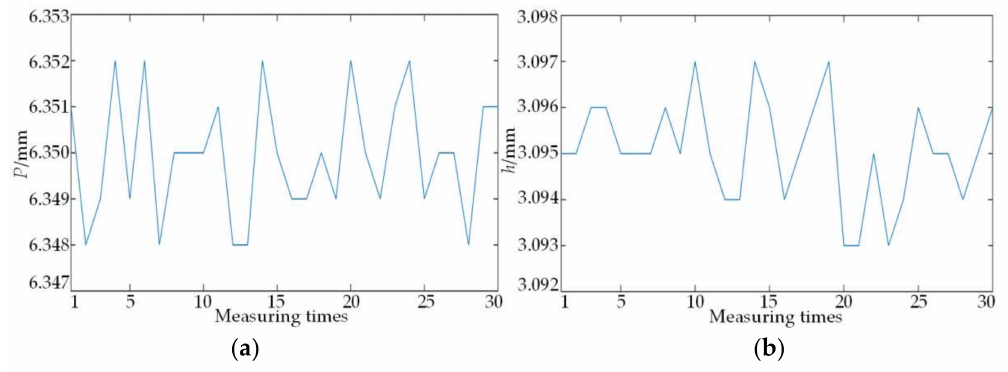
Figure 18. Repeated measuring results. ( a ) Repeated measuring results of pitch; ( b ) repeated measuring results of